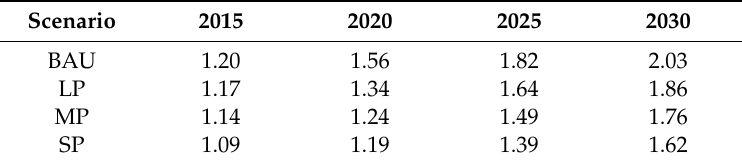
Table 4. The simulation results of energy consumption in Shanghai during the period 2015–2030 (unit: